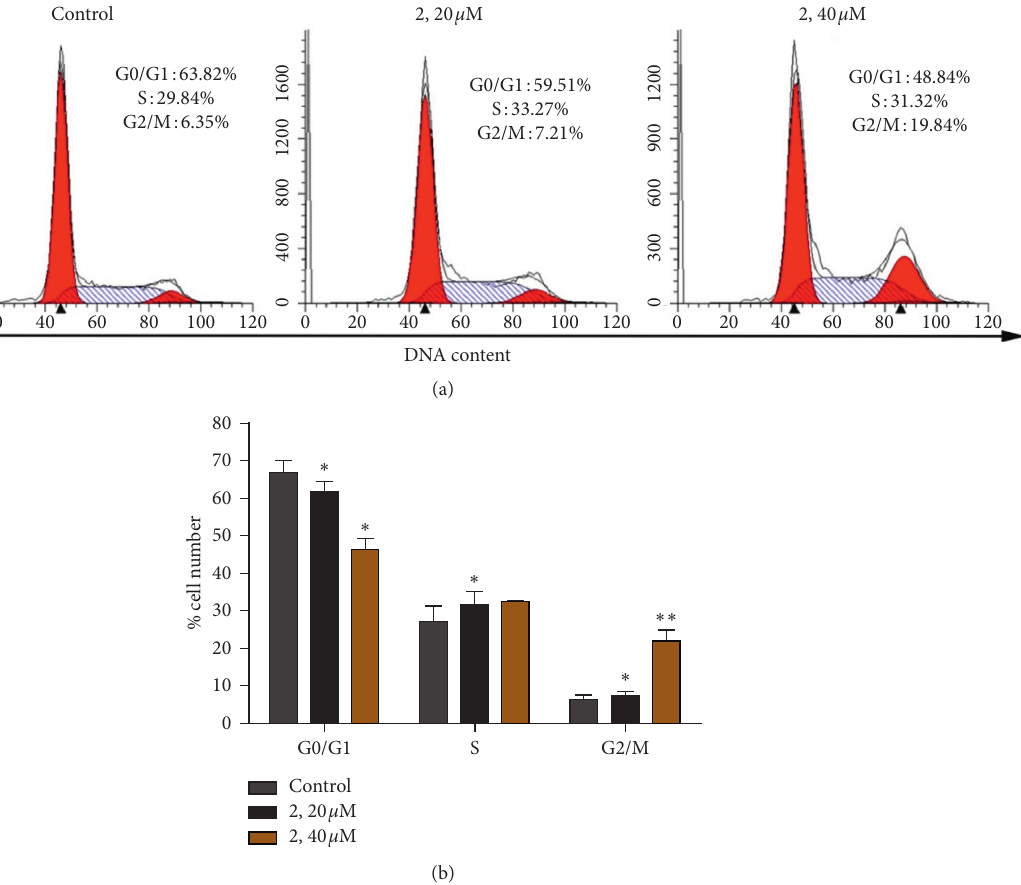
Figure 7: (a) Cell cycle distribution was performed by PI staining after being coincubated with complex 2 (0, 20, and 40 μ M) for 24h. (b) Quantitative data analysis for the number of cells (% of total) in each cell phase for different treatment groups. Data were presented as mean ± SD ( n � 3), Student’s t -test, ∗ P < 0 . 05, ∗∗ P < 0 .